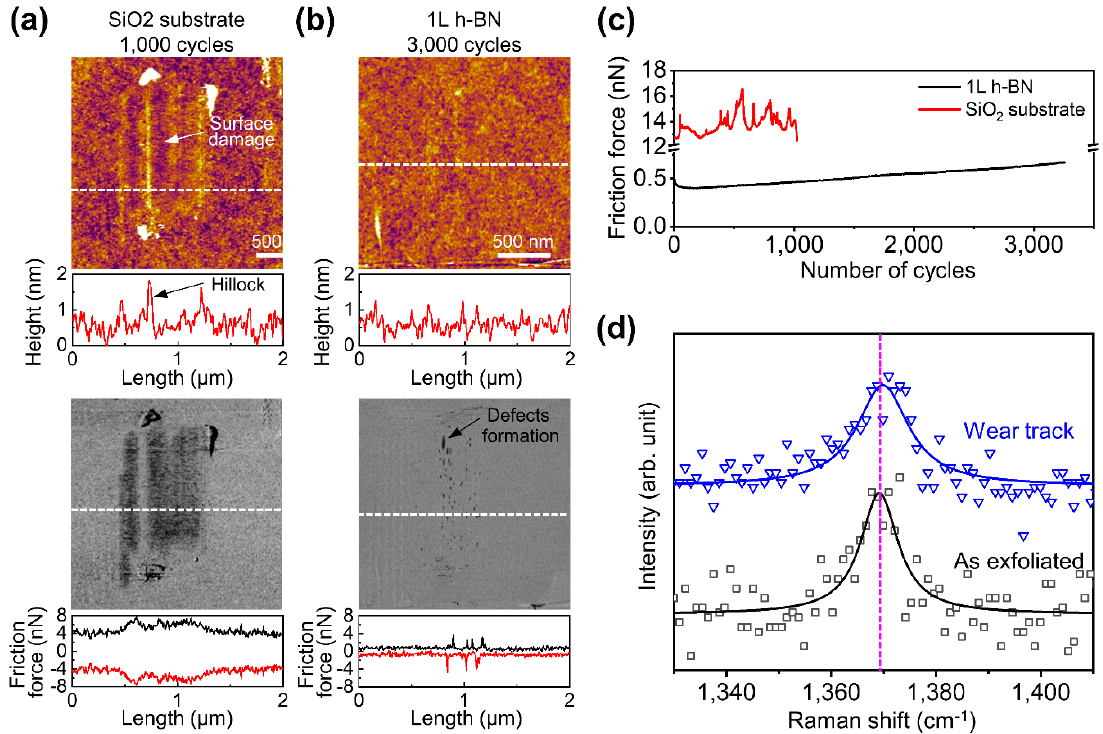
Figure 4. AFM topography images with cross-sectional height profiles and FFM images with friction loops of ( a ) the SiO 2 / Si substrate after 1000 cycles and ( b ) 1L h-BN after 3000 cycles under a 42 µ N normal force, ( c ) the variations of the friction forces with respect to the number of cycles, and ( d ) Raman spectra obtained from the wear track formed on the 1L h-BN in ( b ) and from 1L h-BN before the experiment.